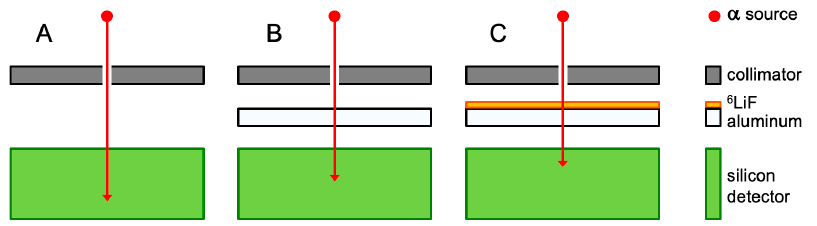
Figure 4. Sketch of the three steps of the measurement of the thickness of the thin layers using an alpha source and a silicon diode. The recorded spectra in the three configurations show peaks at 5.148, 5.477, and 5.794